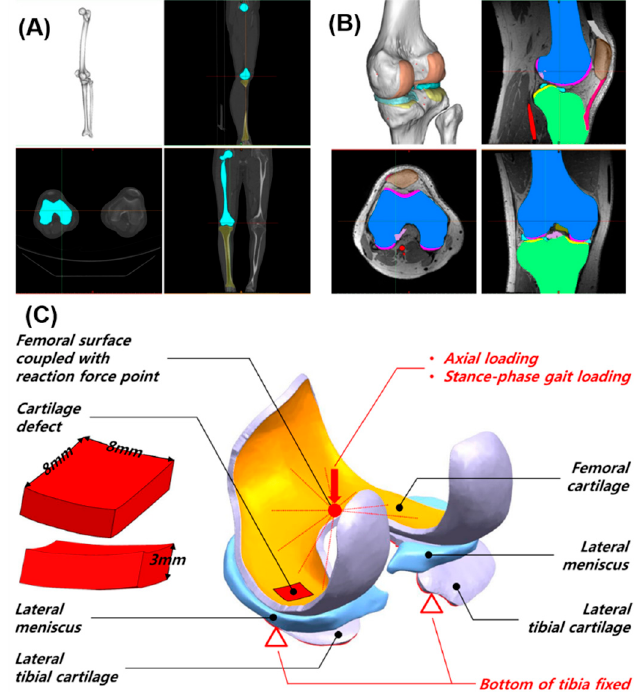
Figure 2. A realistic 3D knee joint model developed using data from ( a ) CT and ( b ) MRI scans. ( c ) Schematic representations of the cartilage defect model and the boundary conditions for cartilage regeneration prediction. Table 1. Material properties used in this simulation.